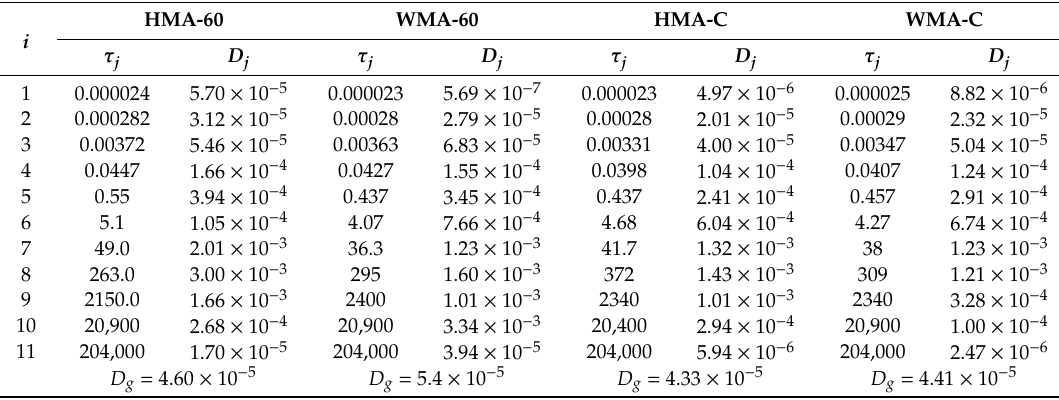
Table A4. Discrete retardation spectrum of crumb rubber-modified asphalt mixture.